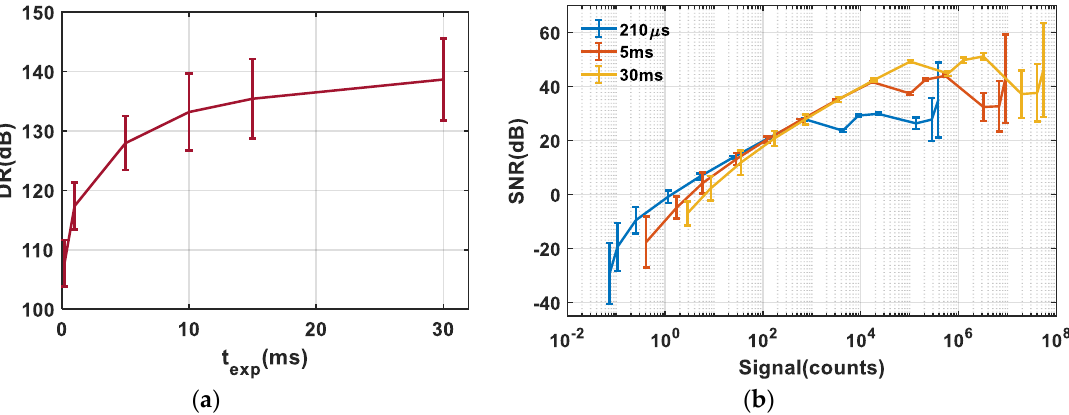
Figure 6. ( a ) Average DR versus integration time for 49 pixels; ( b ) signal-to-noise ratio (SNR) plot for 49 pixels at 210-µs, 5-ms, and 30-ms of exposure time. Error bars describe the uniformity over the 49 pixels.